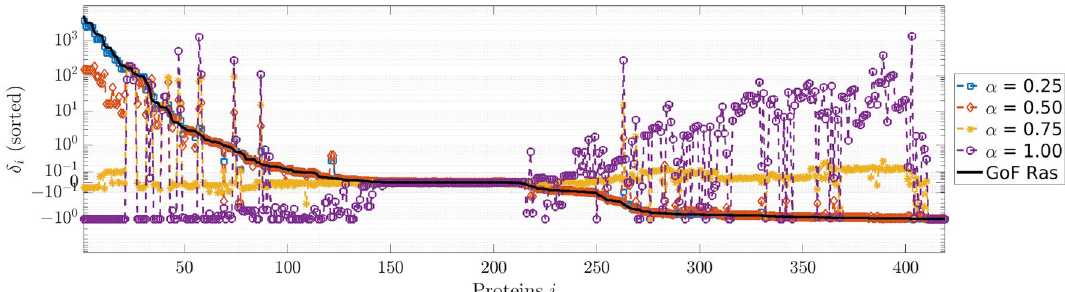
Figure 4. Effects of the drug on the whole protein concentrations profile. The black line represents the relative difference between the concentrations at the equilibrium of the network affected by a GoF of k-Ras and the concentrations at the physiological equilibrium; all the values are sorted in decreasing order. The values δ i for all the proteins are shown in the second column of Supplementary Table S5. The colored lines represent the relative difference between the equilibrium concentrations obtained after the drug addition in the mutated network and the concentrations in the physiological equilibrium. Each color corresponds to a different value of the initial drug concentration, parameterized by α . The values of δ i when α = 0.75 are shown in the third column of Supplementary Table